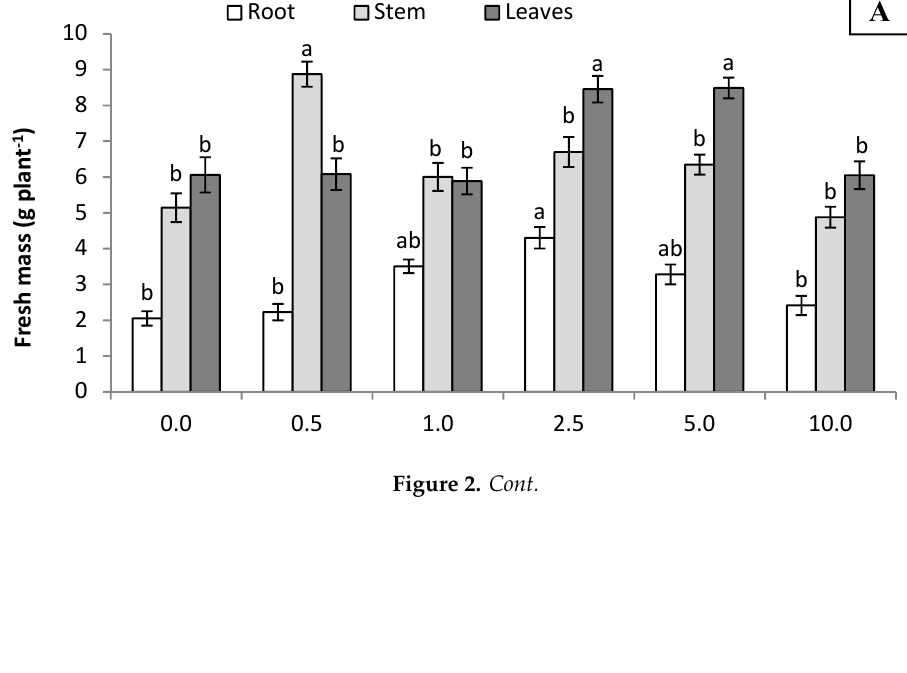
Figure 1. Length ( A ) and volume ( B ) of root and stem systems of Celosia plants fertilized at different rates of fermented alfalfa brown juice applied as a foliar application. Sample size ( n = 6). Different letters above the same columns show significant differences at the level of p < 0.05.